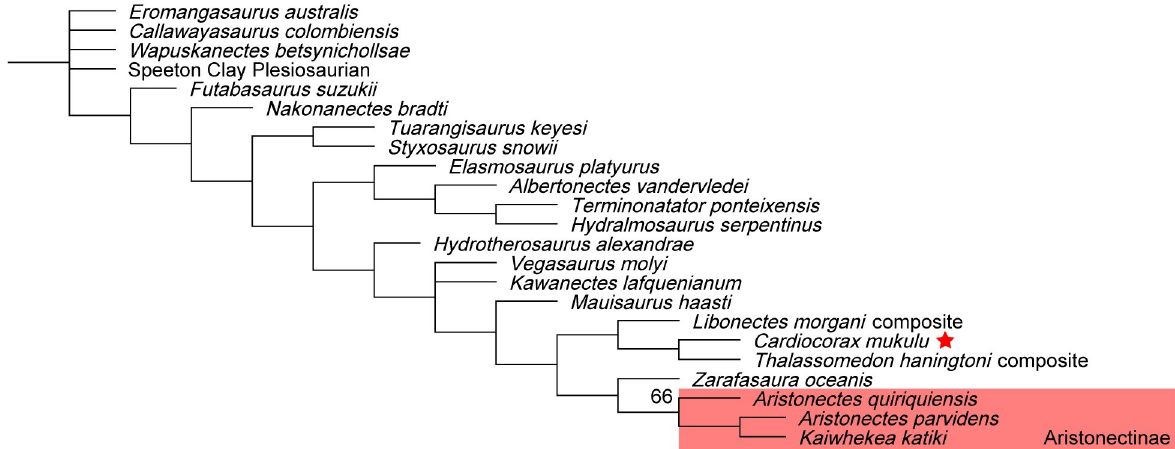
Fig 32. Implied weighting with Sachs et al. (2021) matrix (K = 12). Symmetric resampling values above 50 displayed above nodes.